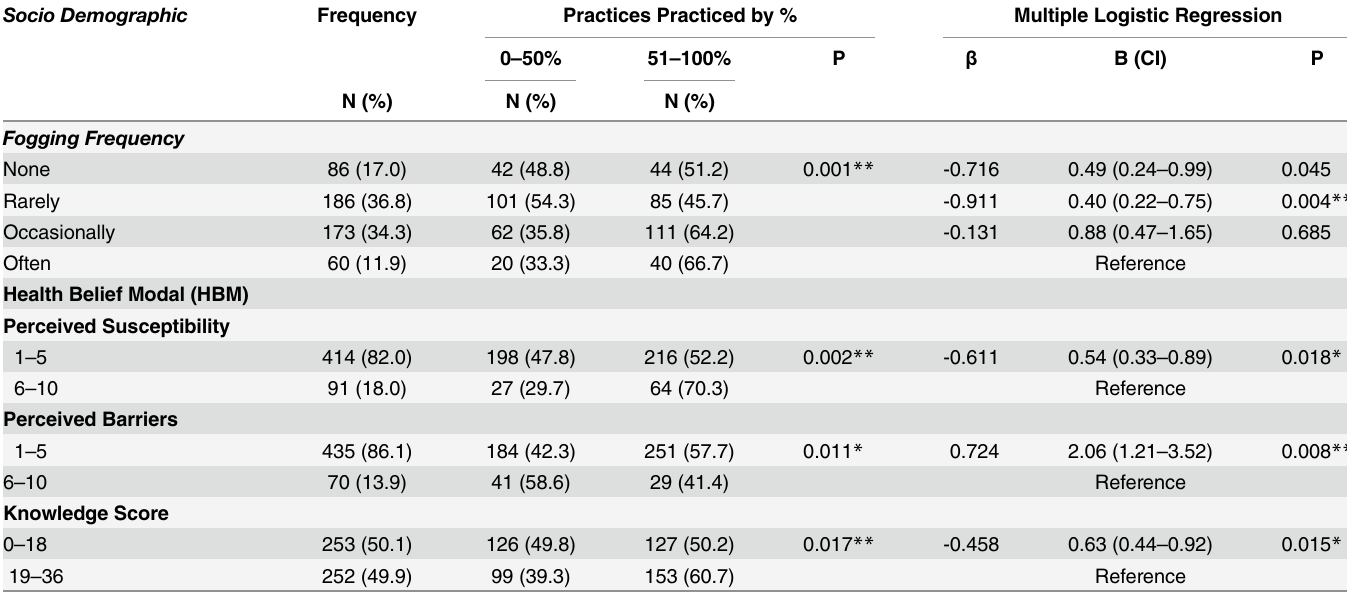
Table 4. Results of logistic regression analyses predicting practices practiced to prevent dengue fever. Socio Demographic Frequency Practices Practiced by % Multiple Logistic